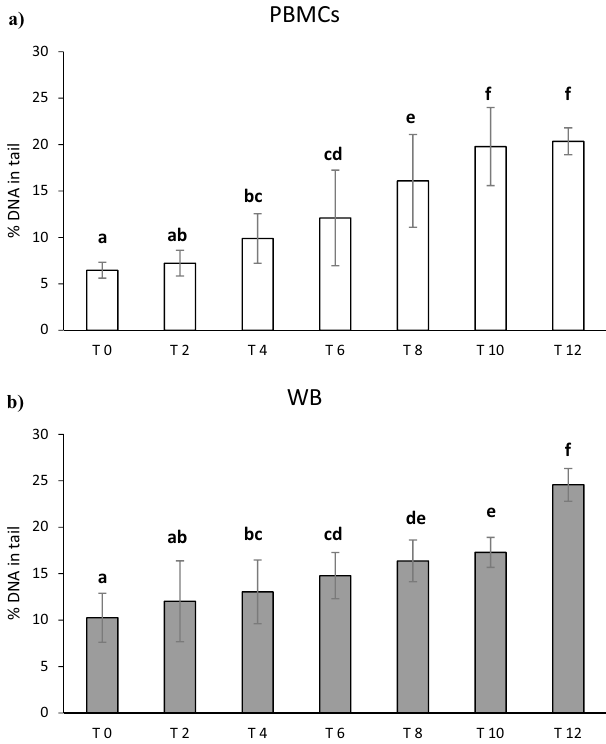
Figure 1. Effect of long-term cryopreservation on DNA strand breaks in PBMCs ( a ) and WB ( b ). T0 refers to fresh samples that have been processed in the comet assay without cryopreservation. T2–T12 are samples that have been cryopreserved between 2 and 12 months. Data are reported as mean ± standard deviation (SD); PBMCs peripheral blood mononuclear cells, WB whole blood. a,b,c,d,e,f Data with different letters are significantly different ( p <